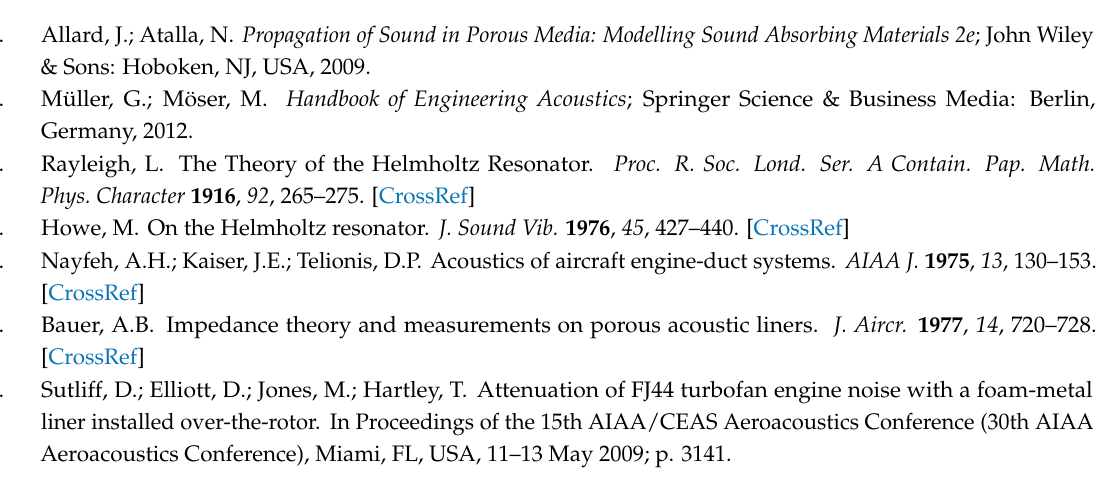
Figure A3. Microscopic cross-sectional views of cut Ref 2